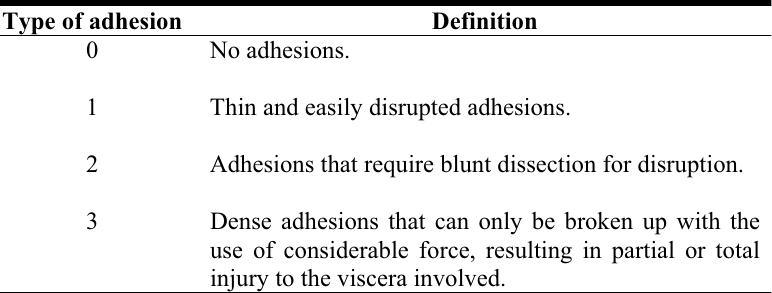
TABLE 1 - Classification of adhesions by direct visualization after U-shaped incision in the abdominal